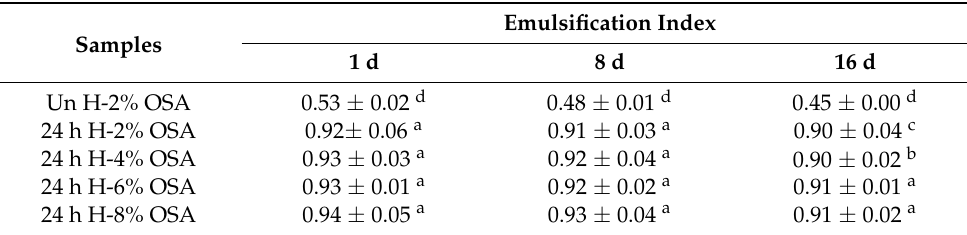
Table 3. The emulsification index (EI) of modified-PMS-starch-stabilized Pickering emulsions follow- ing different conditions on different